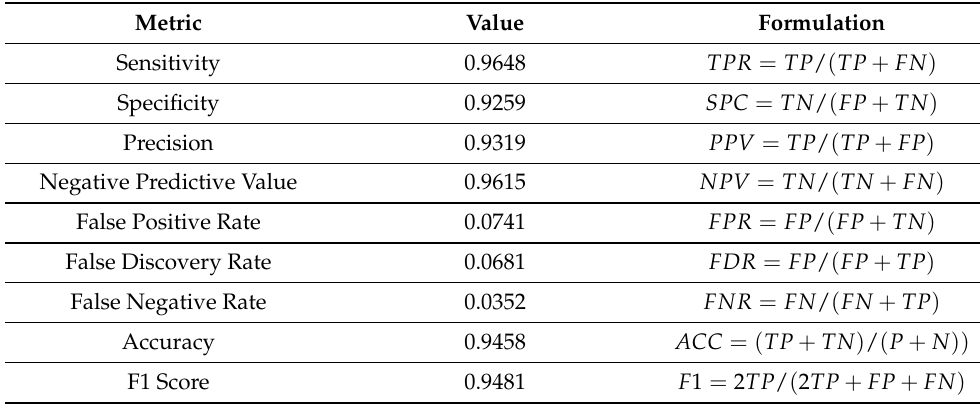
Table 10. Accuracy, precision, recall and F1 score based on confusion